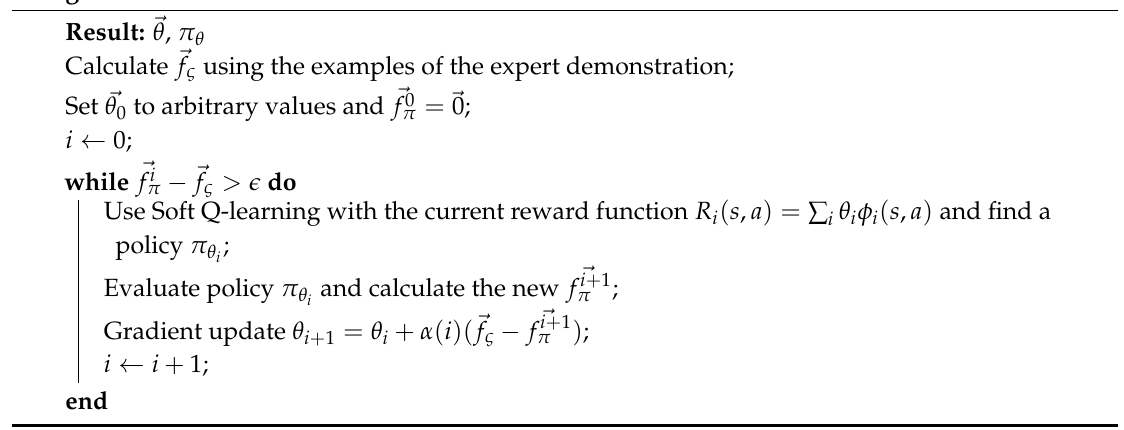
Algorithm 1: Iterative schema for the model-free